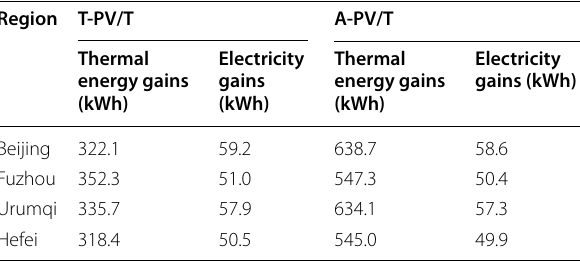
Table 1 Annual performance comparison of A-PV/T and T-PV/T in Beijing, Fuzhou, Urumqi, and